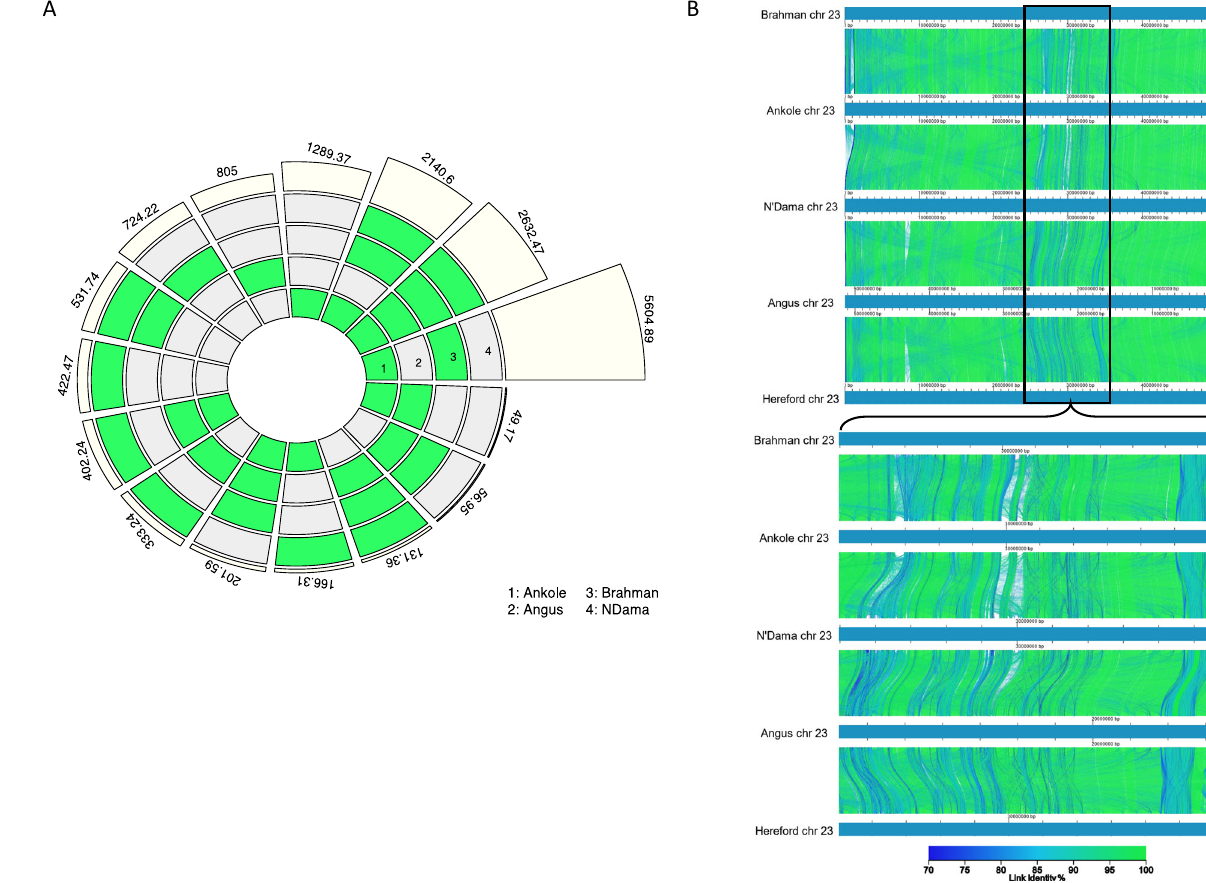
Fig. 3 Comparison of genomic content across the genomes. A High-quality (NOVEL) sequence speci fi c to, or shared among, each non-reference genome. Numbers represent the kilobases of non-Hereford sequence associated with the set of genomes de fi ned by the group(s) highlighted in green. Each genome is indicated by a number (1 = Ankole, 2 = Angus, 3 = Brahman and 4 = N ’ Dama); B Multiple genome alignments of the MHC region on chromosome 23 generated with AliTV (v1.0.6) 75 . The plot represents the shared sequences among the different genomes; blue to green segments are representative of higher to lower similarity (100 to 70% respectively); the enlarged region is the MHC region, which shows a large amount of variation between the